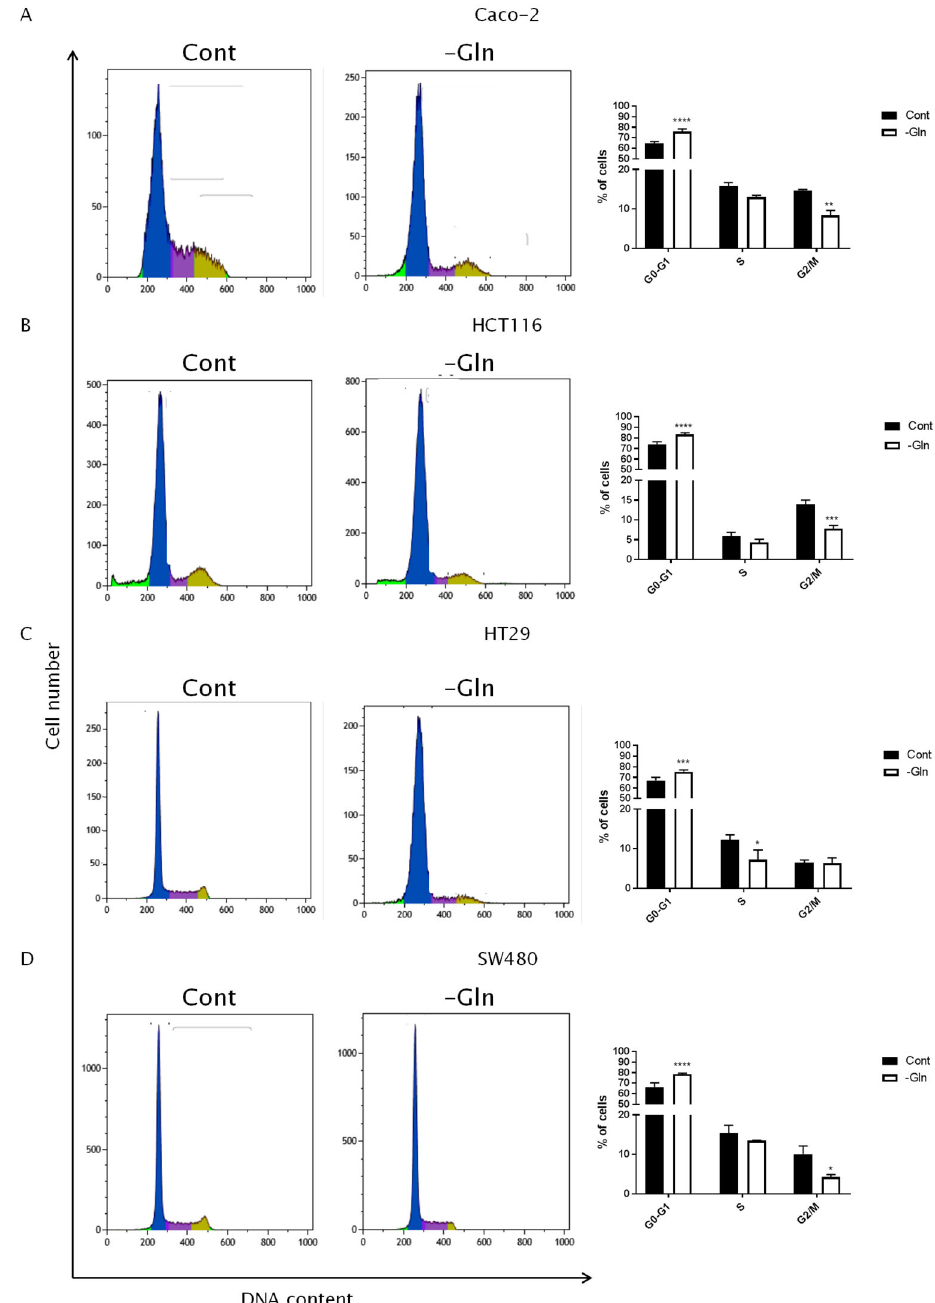
Cell death was evaluated in colorectal cancer cells in the presence (Cont) or absence ( ‐ Gln) of glu ‐ tamine for 48 h using flow cytometry combined with annexin V and propidium iodide staining. Data were expressed as cell percentages; the experiment was performed in triplicate and represents mean ± SD; ns : not significant.